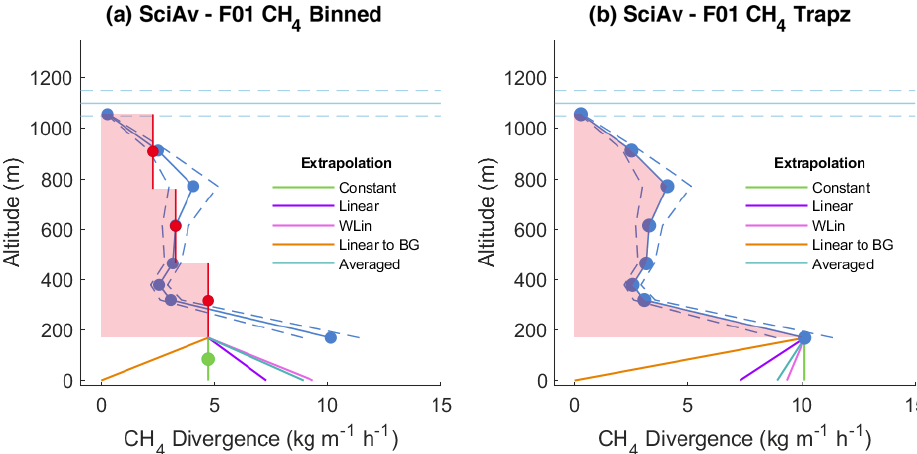
Figure 4. The two different integration methods applied to the SciAv F01 CH4 profile are depicted as the red area. Figure (a) shows the standard binning method of estimating an average flux divergence for each bin and integrating by altitude over the area as rectangular boxes. Figure (b) shows the trapezoidal (Trapz) method of estimating an average area under the curve by connecting the flux divergence lap points. The boundary layer height is drawn in light blue with error bars (light blue dashed lines). Both figures do not include the extra emissions that would be included using surface